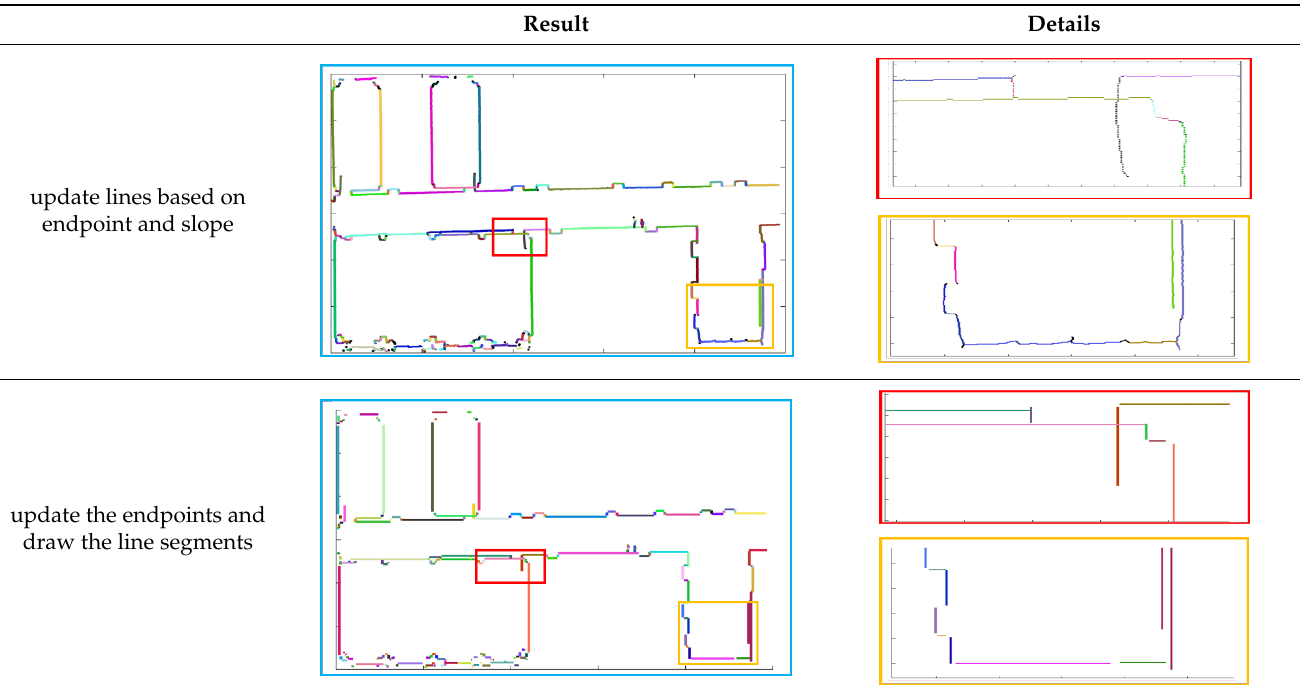
Figure 18. The result of line correction. All the lines that satisfy the condition are connected and we show them in detail.